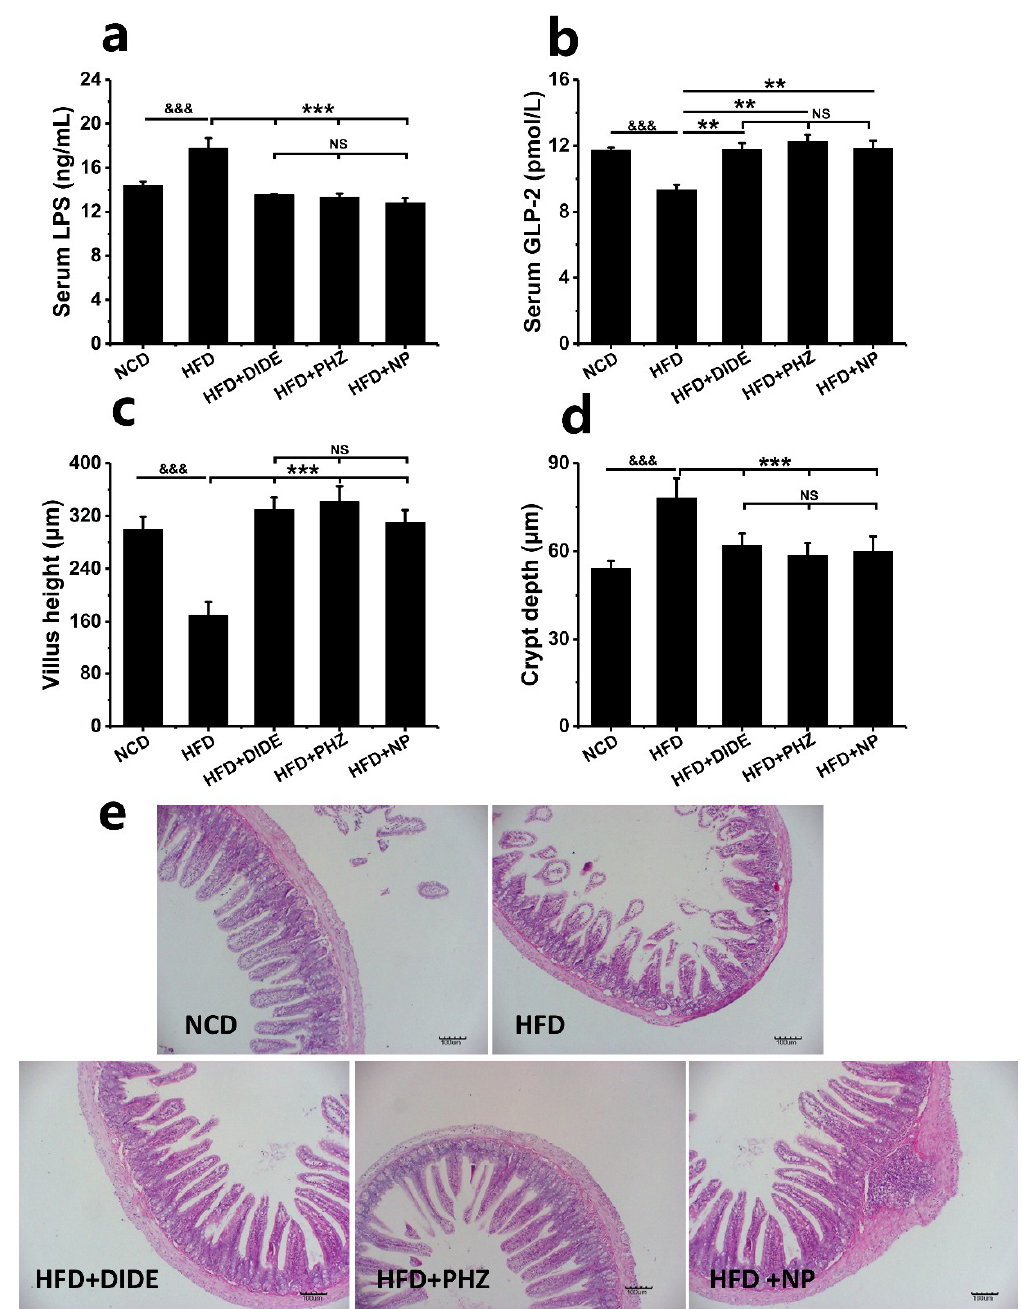
Figure 6. Effects of DIDE, PHZ, and NP on serum LPS, GLP-2 and jejunum barrier function (n =10 per group). ( a ) serum LPS. ( b ) serum GLP-2. ( c ) villus height. ( d ) crypt depth. ( e ) jejunum morphology.